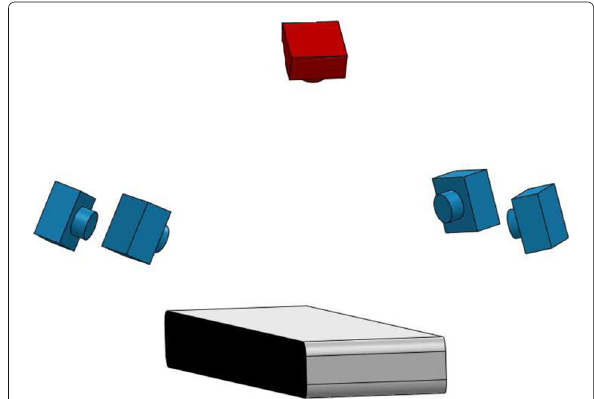
Fig. 1 Camera and treadmill arena. Four side view cameras are used for capturing high-speed kinematics, and one camera above (red) provided tracking of the animal and adjusted the speed of the belt using the closed-loop feedback method of Spence et al.